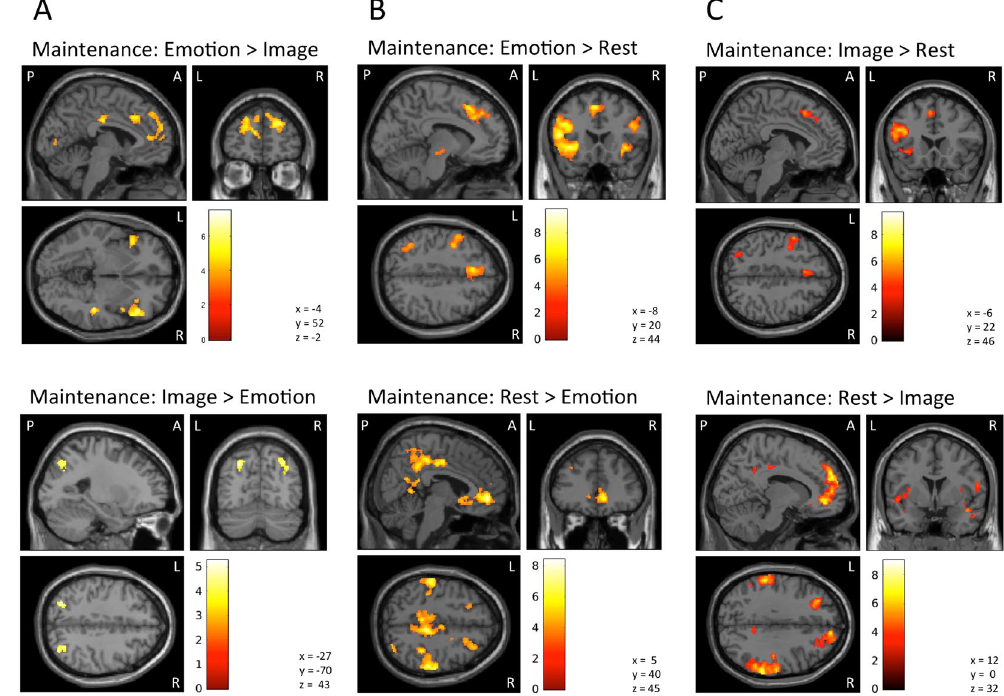
Figure 2. Illustration of the imaging results contrasting the maintenance period of the ( A ) “Emotion” and “Image” conditions, ( B ) “Emotion” and “Rest” conditions, and ( C ) the “Image” and “Rest” conditions. Images are thresholded using a peak threshold of p < 0.001 (uncorrected) and a cluster threshold of p < 0.05, FDR- corrected. Images are shown in neurological orientation (L = left; R = right; P = Posterior; A =